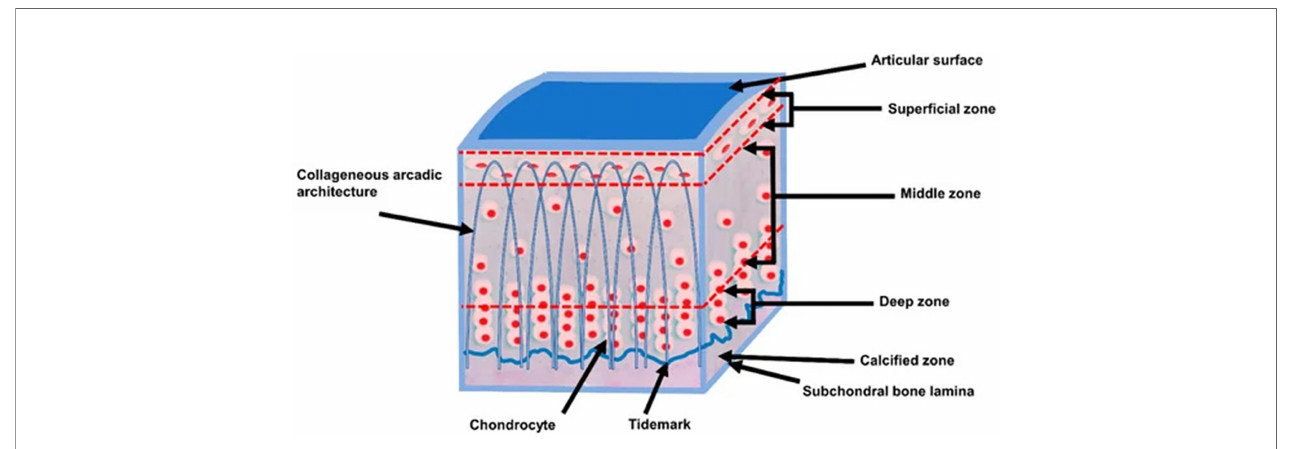
FIGURE 1 | The schematic cross sectional layers of articular cartilage. Articular cartilage consists of four different layers, namely the super fi cial, middle, deep, and calci fi ed layers. Modi fi ed, with permission under Creative Common Attribution License from Ref